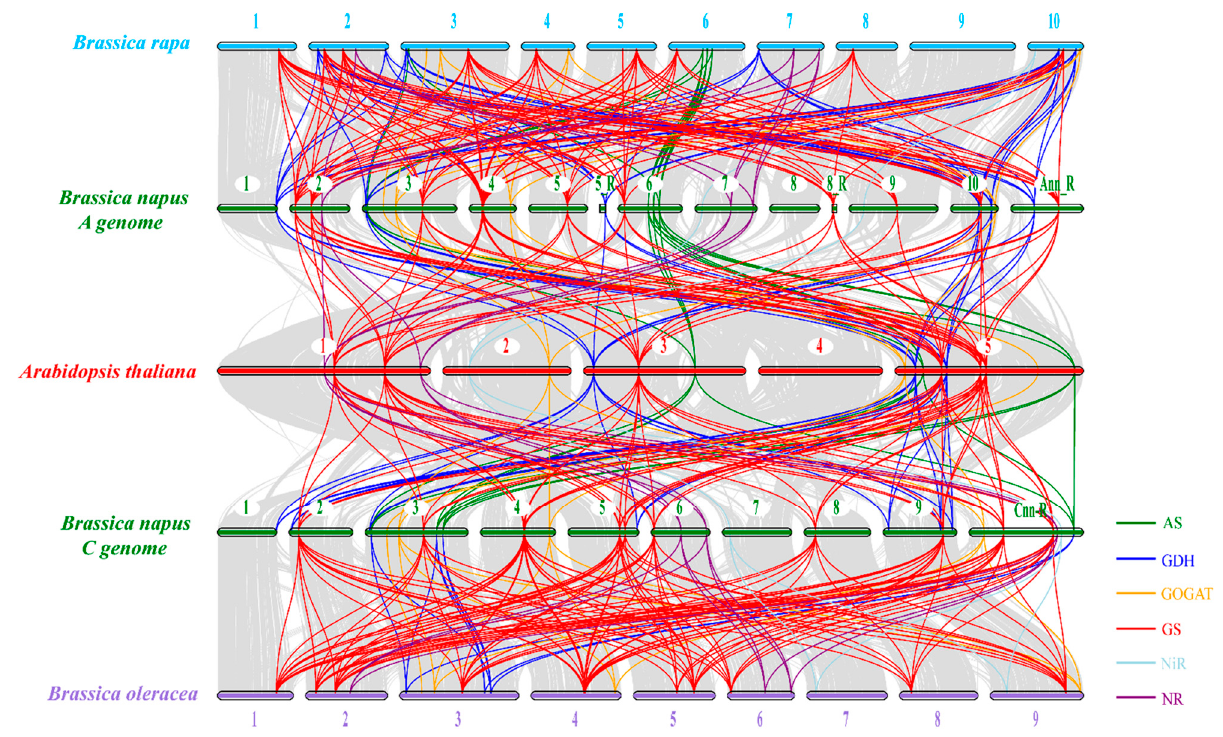
Figure 4. Synteny analysis of the nitrogen assimilation-related genes in Brassica napus , B. rapa , B. oleracea and Arabidopsis thaliana chromosomes. Gray lines in the background indicate all syntenic blocks between the genomes of B. napus and other species, while the lines with different colors indicate syntenic gene pairs of each family. The green, blue, yellow, red, cyan and purple color lines indicate asparagine synthetase (AS), glutamate dehydrogenase (GDH), glutamine oxoglutarate aminotransferase (GOGAT), glutamine synthetase (GS), nitrite reductase (NiR), nitrate reductase (NR) family gene pairs, respectively.